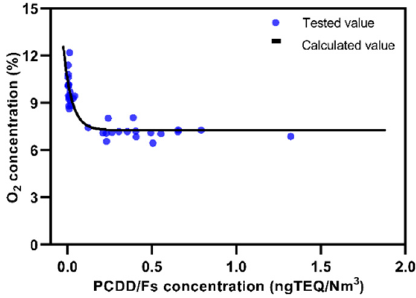
Figure 3. Comparison of the calculated value and tested value (six group tested values).